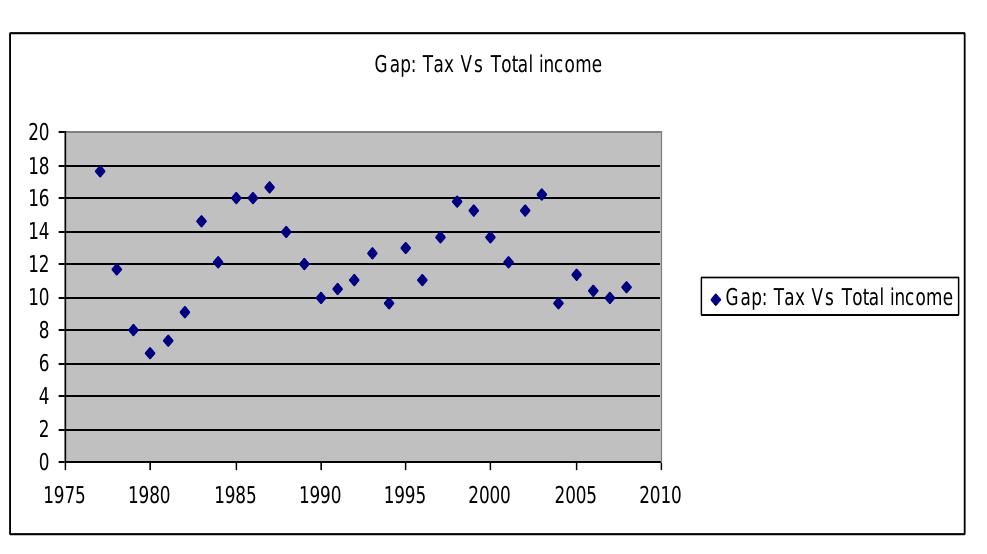
Figure 4: Gap between Total Government Revenue and Tax Revenue Source: Central Bank of Sri Lanka, Annual Reports